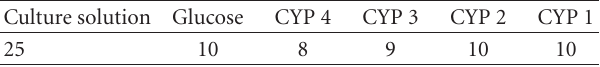
Table 8: E ff ects of Chinese Yam polysaccharide (CYP) and glucose on the complexity of the intestinal bacterial population in fermentation